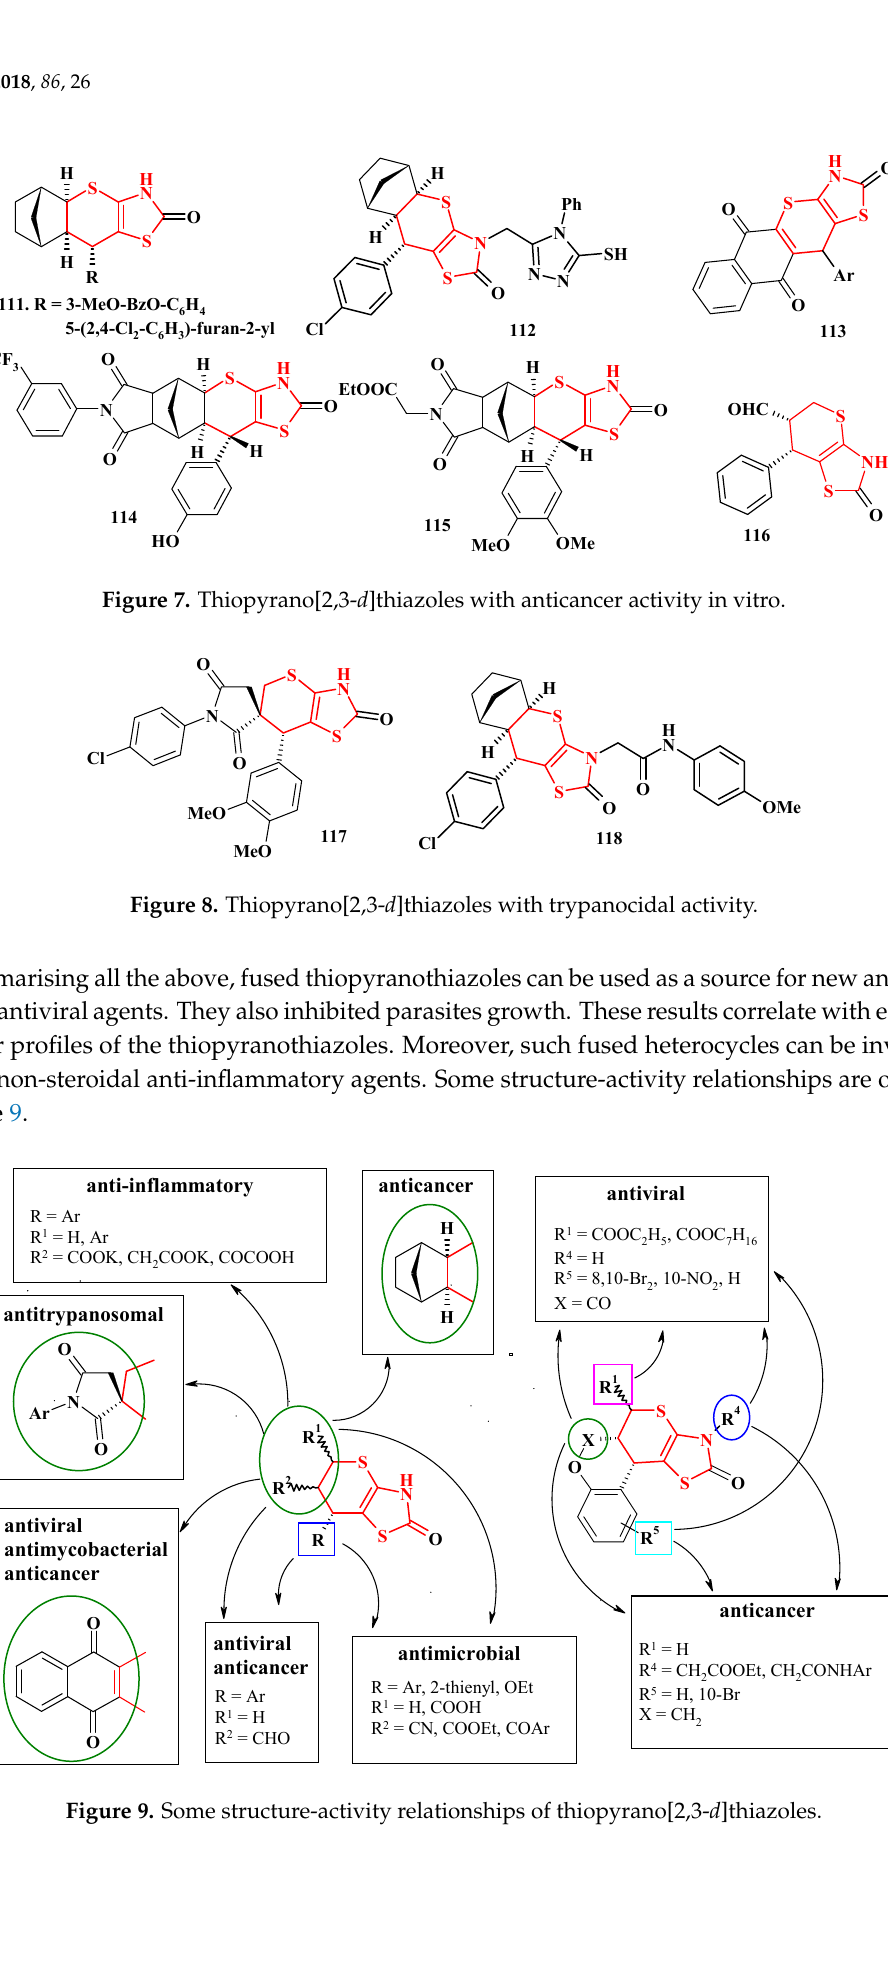
review. One of the most studied synthetic protocol for thiopyranothiazoles is the hetero -Diels–Alder [4+2]-cycloaddition being rather fast and efficient method that yields good outcomes and stereoselectivity of the products. The tandem processes based on hetero -Diels–Alder and Michael reactions used for the thiopirano[2,3- d ]thiazoles synthesis have also been discussed. In contrast to the well discribed various synthetic routes of thiopyranothiazoles synthesis, biological activity of these derivatives have not been studied that much. Nevertheless, they are considered as 5-ene-4- thiazolidinone synthetic biomimetics that save pharmacological profile without revealing Michael acceptors properties. Among established biological activities of the thiopyrano[2,3- d ]thiazole derivatives, the anti-inflammatory, antibacterial, anticancer as well as aniparasitic activities are the most prominent and need further in-depth studies. Considering all the above, the directed search for new drug-like molecules and possible chemotherapeutic agents among thiopyrano[2,3- d ]thiazole derivatives is justified and promising direction in the medicinal chemistry. Moreover, the way of annealing of thiazolidine core into thiopyranothiazole analogs is used as one of the molecular optimization directions to decrease the toxicity and/or avoid the Michael acceptor properties as well. Author Contributions: R.L. conceived and designed the review; O.R. and A.L. analyzed the literature data; R.L. and A.K. wrote the paper. All authors read and approved the final manuscript. Funding: The project was partly supported by State Fund for Fundamental Research of Ukraine (F76/72-2017) and Ministry of Education and Science of Ukraine (M/181-2017). Acknowledgments: This research was supported by the Danylo Halytsky Lviv National Medical University, which is gratefully acknowledged. Conflicts of Interest: The authors declare no conflict of interest. References 1.